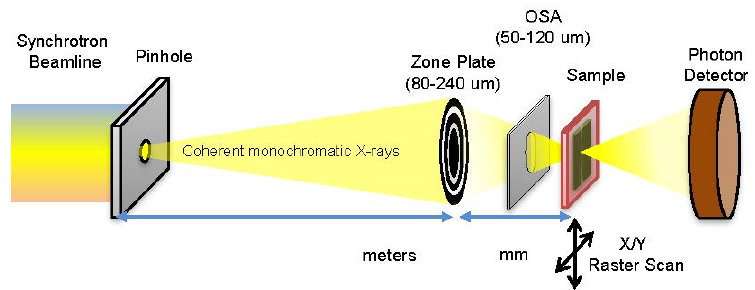
Figure 1. STXM operation principle (adapted from [36]): A FZP is illuminated by monochromatic, coherent X-ray light provided by a synchrotron beamline. The light is focused through an OSA (which blocks unwanted diffraction orders of the FZP) onto a focal spot on the sample. The transmitted photons are recorded by an X-ray photon detector, which allows probing of the local absorption of the sample, and therefore, usage of contrast mechanisms such as XAS (X-ray absorption spectroscopy), NEXAFS (Near edge X-ray absorption fine structure) and XMCD for elemental, chemical or magnetic contrast, respectively. The image is generated by raster scanning the sample through the stationary beam, with the lateral resolution being given by the size of the X-ray spot (which under fully coherent illumination is about 1.2 times the outermost zone width of the FZP).